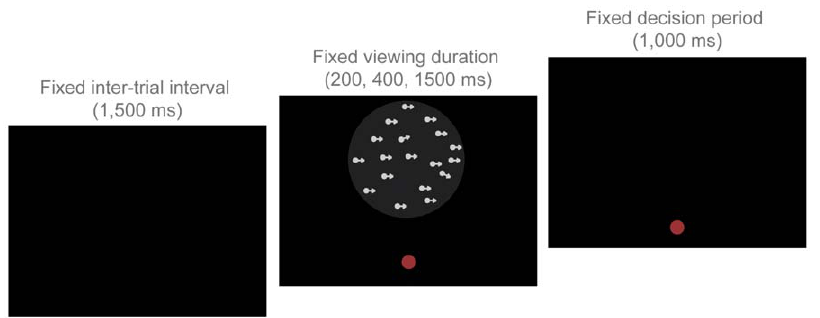
Figure 2. One trial of the motion coherence task. Participants manually indicated the ‘‘general direction of motion’’ of 150 white dots in a central aperture above a fixation point. Viewing duration varied between blocks (200 ms–1500 ms), but the decision period remained constant regardless of viewing duration.